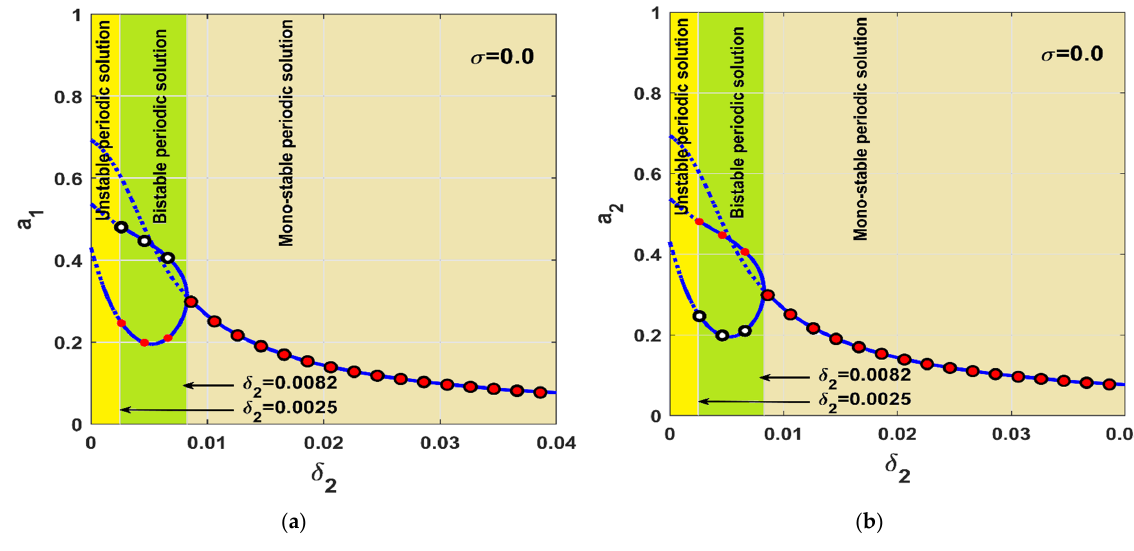
Figure 16. 𝛿 (cid:2870) − response curve of the controlled Jeffcott rotor (i.e., 𝐸 = 0.03,𝜆 = 0.05 , and 𝛿 (cid:2869) = Figure 16. δ 2 —response curve of the controlled Jeffcott rotor (i.e., E = 0.03, λ = 0.05, and δ 1 = 0.83): 0.83 ): ( a ) oscillation amplitude 𝑎 (cid:2869) versus 𝛿 (cid:2870) when 𝜎 = 0 , and ( b ) oscillation amplitude 𝑎 (cid:2870) versus ( a ) oscillation amplitude a 1 versus δ 2 when σ = 0, and ( b ) oscillation amplitude a 2 versus δ 2 when 𝛿 (cid:2870) when 𝜎 = 0 . σ = 0.